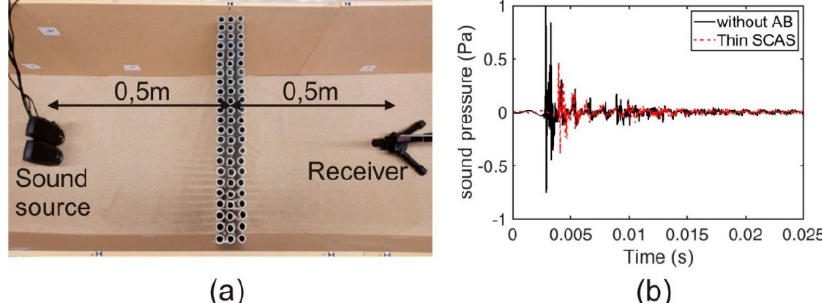
Figure 3. ( a ) Plan view of the experimental set up (loudspeakers and condenser microphone) and the position of the different ABs; ( b ) Examples of the impulse-response spectra for two cases: without AB (black solid line) and with thin Sonic Crystal Acoustic Screen (SCAS) (red dashed line).